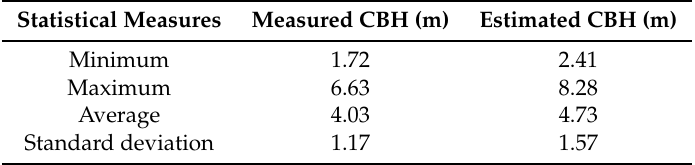
Table 3. Statistical summary of the field measured and voxel-based estimated